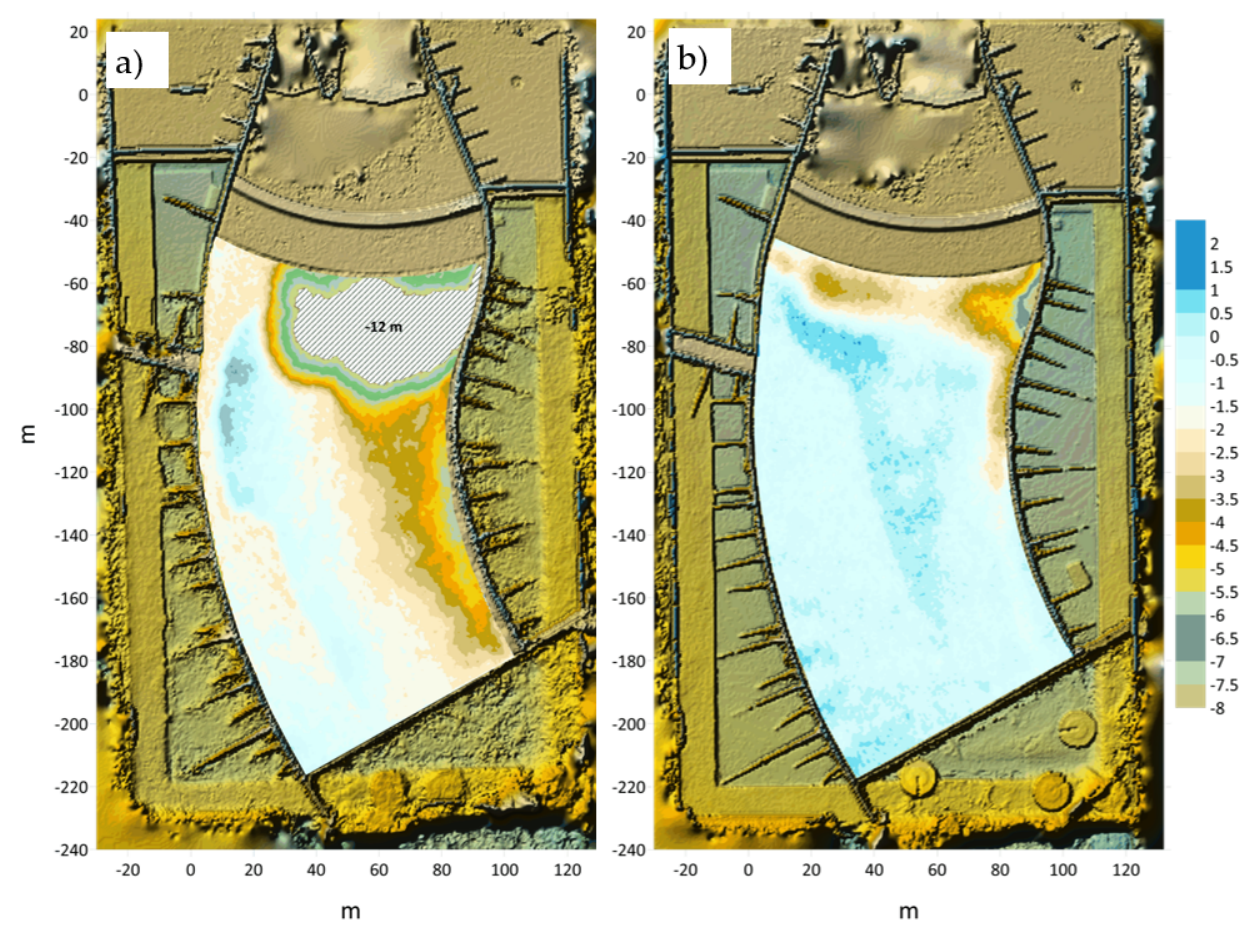
Figure 11. Erosion/deposition maps (dimensions in meters) reconstructed processing images of ( a ) Test #3a and ( b ) Test #3b; for both tests, the discharge was set to 1450 m 3 /s. The ski jump sill is in place during Test #3a (left-hand side panel) whereas it is removed during Test #3b (right-hand side panel).